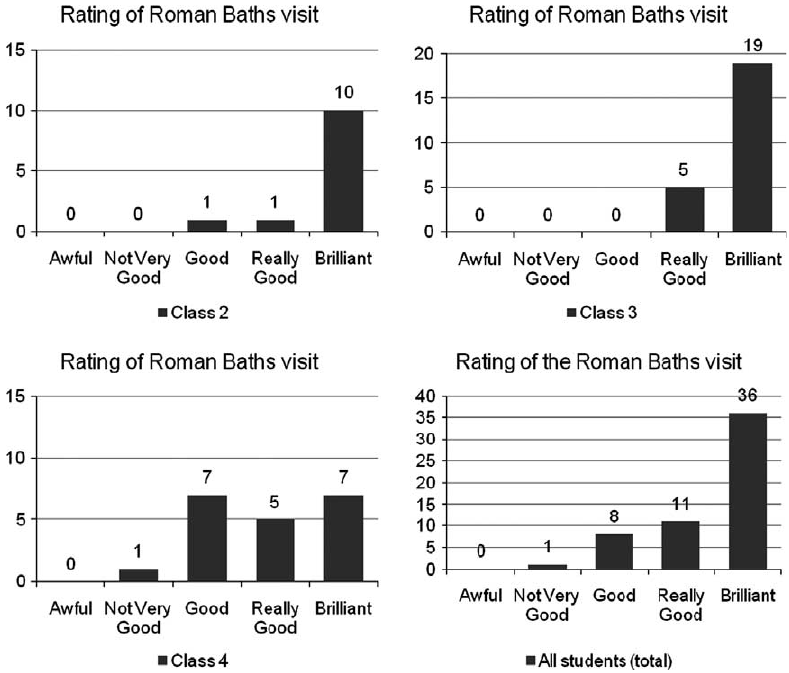
Figure 3. The students’ ratings of their visit to the Roman Baths, for each class and